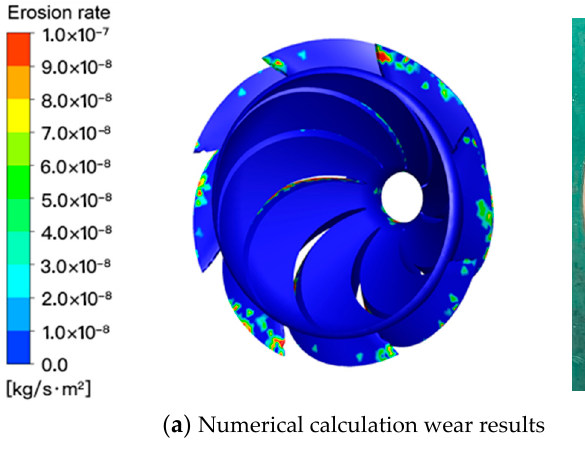
Figure 28. Comparison of the wear at the first stage guide vane.